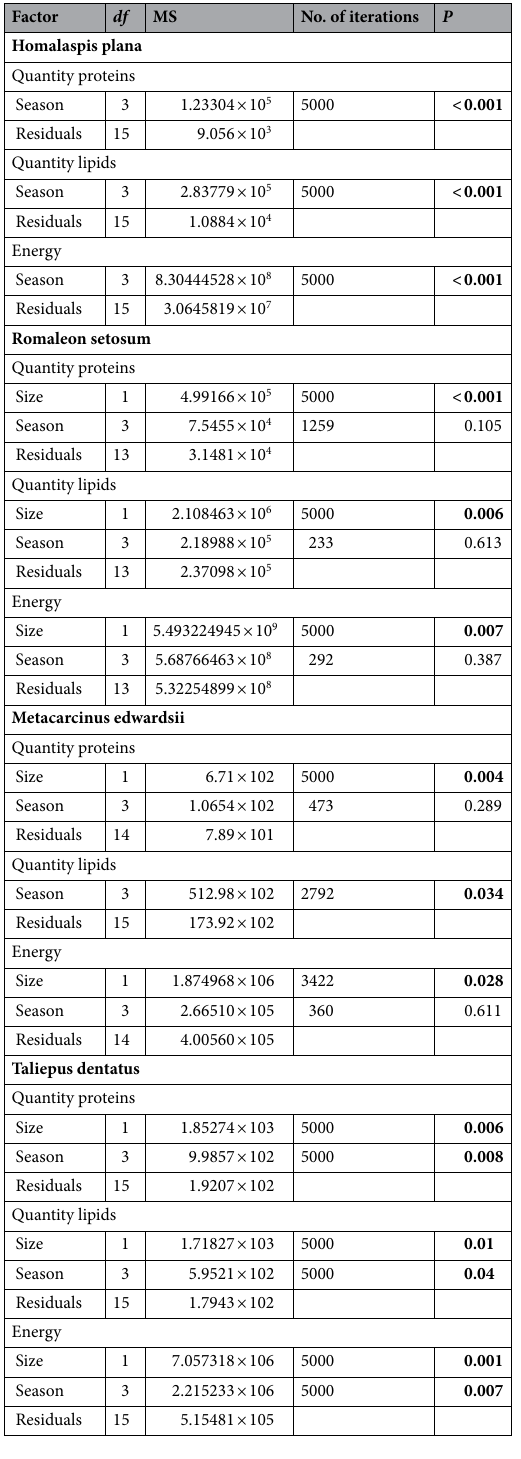
Table 2. Permutation tests of the linear model comparing the effects of size (covariate) and season (fixed factor) on quantity of each biochemical component and energy in crab species. Bold indicates significant differences ( P < 0.05). Note that analyses of Homalaspis plana and quantity of lipids of Metacarcinus edwardsii do not include size as a